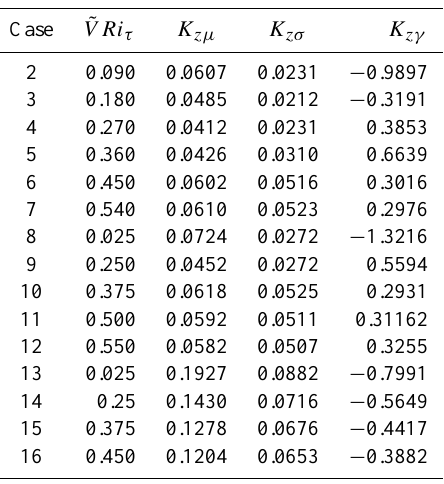
Table 2. The table lists all the cases of direct numerical simulations used in the current study along with ˜ V Ri τ for each of the cases. ˜ V Ri τ is a parameter which represents the level of self-stratification; and a higher value of ˜ V Ri τ corresponds to a higher level self- stratification if Re τ remains constant. Cases 1–12 correspond to the simulations for channel configuration and 13–16 correspond to the simulations for open-channel-like configuration. The corresponding sediment diffusivity profiles were quantified using Eq. (10), and the calculated parameters K zµ , K zσ , K zγ have also been listed in the table. K zµ parameterizes the mean sediment diffusivity, K zσ pa- rameterizes the variance in the sediment diffusivity profile and K zγ parameterizes the skewness of the sediment diffusivity